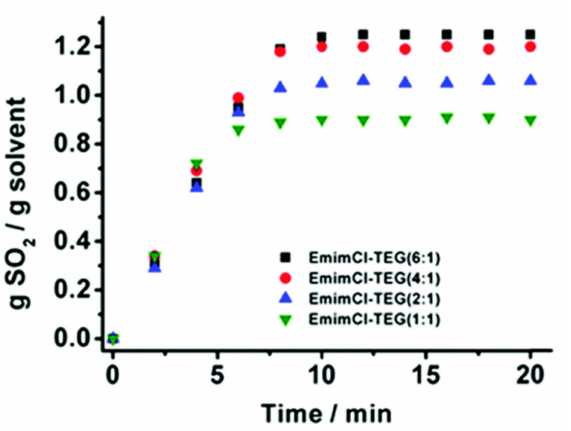
Figure 1. Comparison of SO 2 absorption by EmimCl:TEG DESs with different molar ratios as a function of time at 293.15 K and 101 kPa (Reprinted with permission from Ref[42]. Copyright (2018)